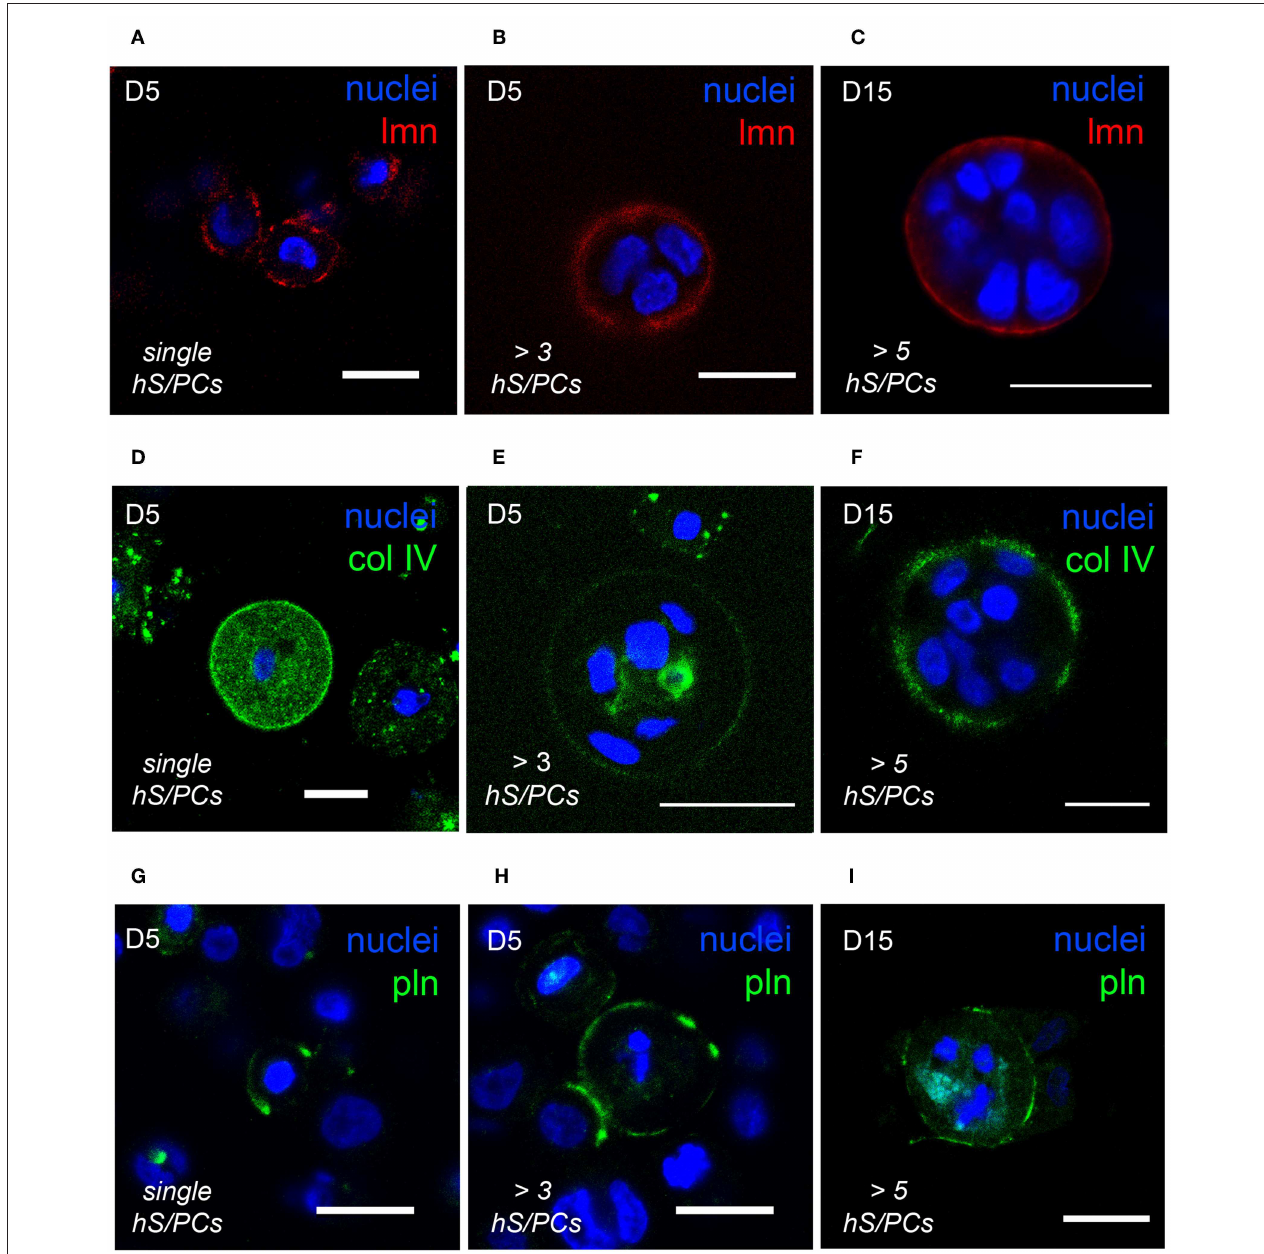
FIGURE 2 | hS/PCs sequentially secrete basement membrane proteins during microstructure reorganization and function. Encapsulated hS/PCs in HA-PEGDA hydrogels initially produce laminin (red) (A–C) and collagen IV (green) (D–F) even at the single-cell state (A,D) . Perlecan (green) (G–I) secretion follows to stabilize the laminin and collagen IV networks. Scalebar = 20 µ m in all confocal